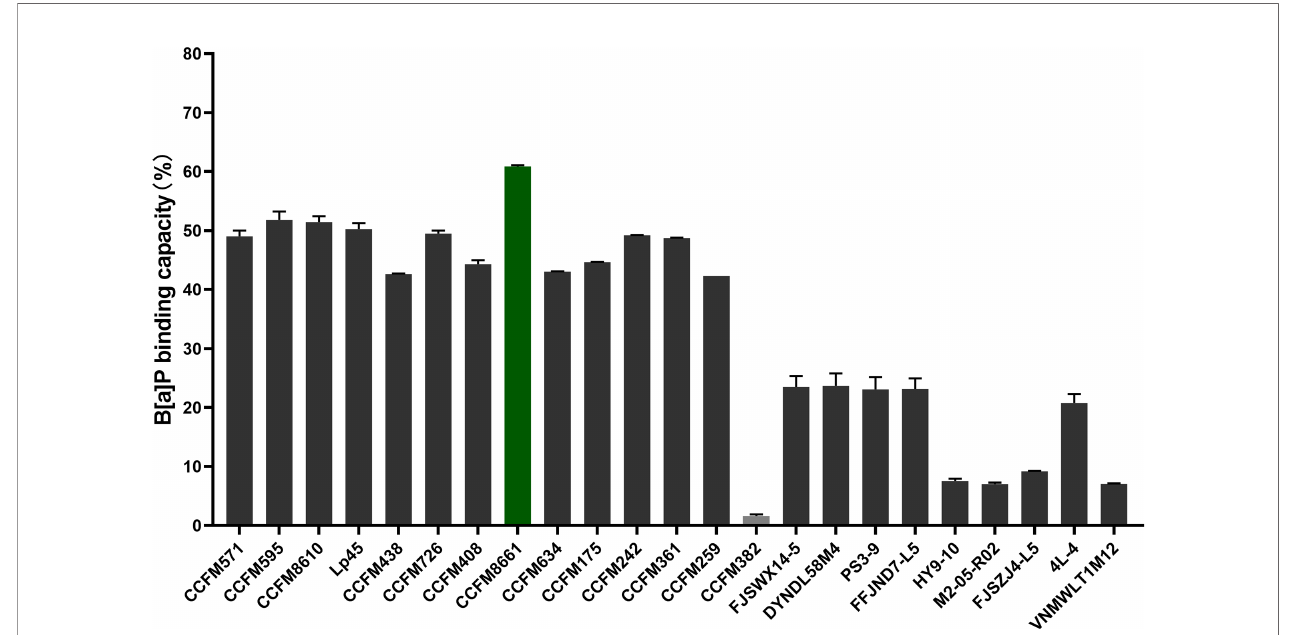
FIGURE 1 | B[ a ]P-binding capacity of L. plantarum